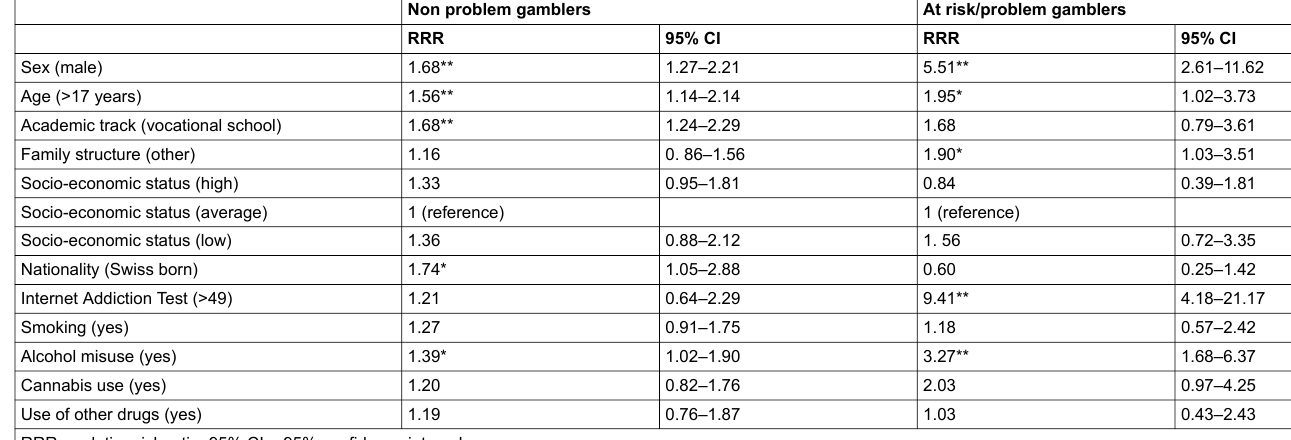
Table 3: Multinominal logistic regression using nongamblers as reference